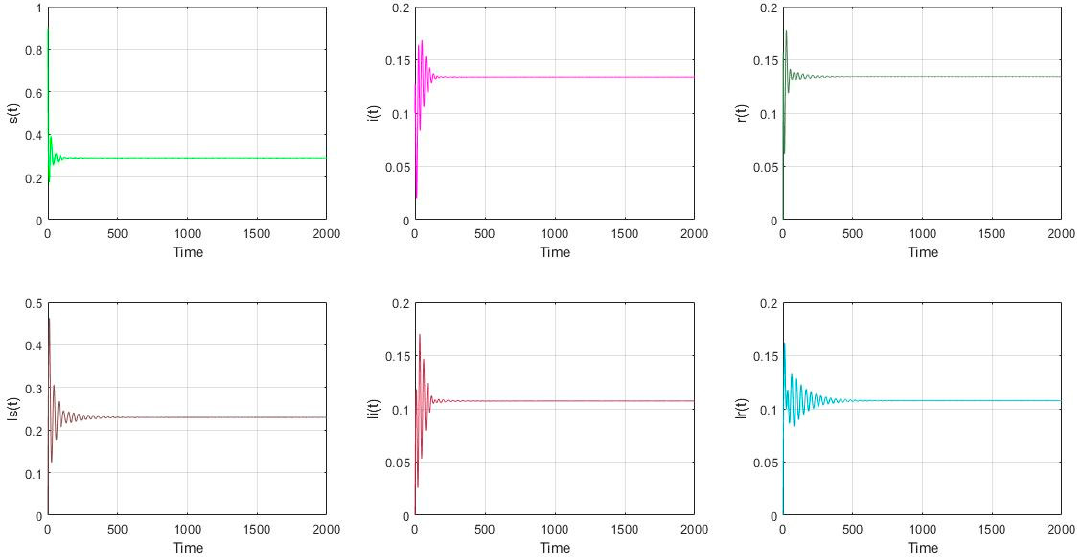
Figure 6. The distribution of nodes if R 0 = 1.4029 and τ = 10.25 < τ 0 = 11.5370.